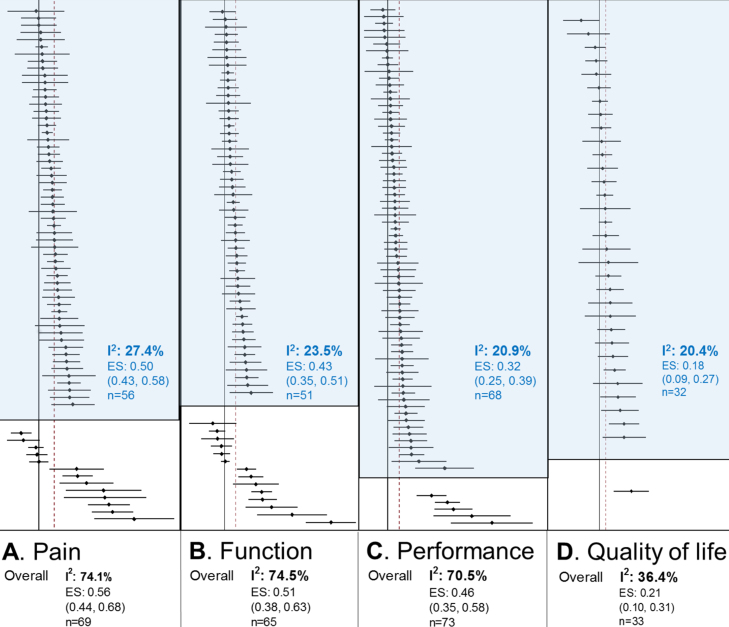
Effect size (ES) for all outcomes by including only “homogeneous” studies (blue shaded area). Blue text: results obtained when sources of heterogeneity (studies in unshaded area) were removed to achieve I2 < 30%. Overall results refer to original estimate obtained with all studies. Data in parenthesis represent 95% confidence interval, I2: I2 statistic, n: number of studies.